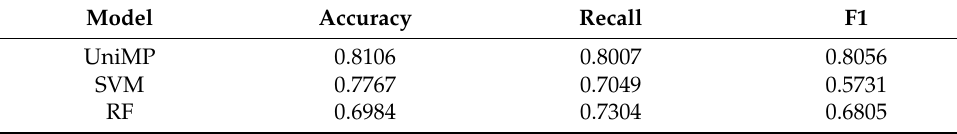
Table 1. Results of UniMP, SVM and RF.